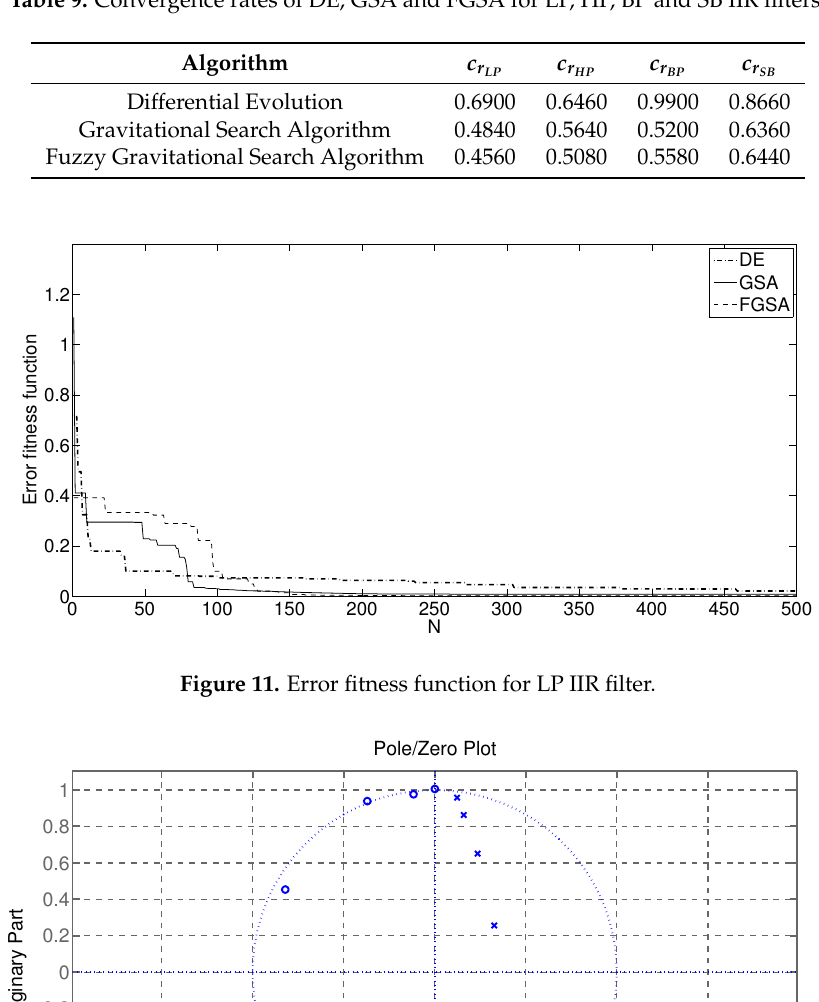
Table 9. Convergence rates of DE, GSA and FGSA for LP, HP, BP and SB IIR filters.